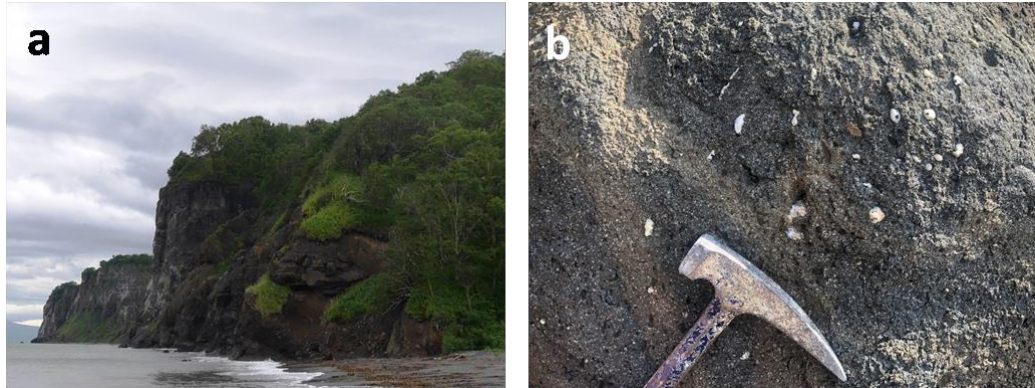
Figure 2. ( a ) Coastal outcrops of Shlyupochnaya Bay (Avacha Bay, Eastern Kamchatka, Russia) (photo